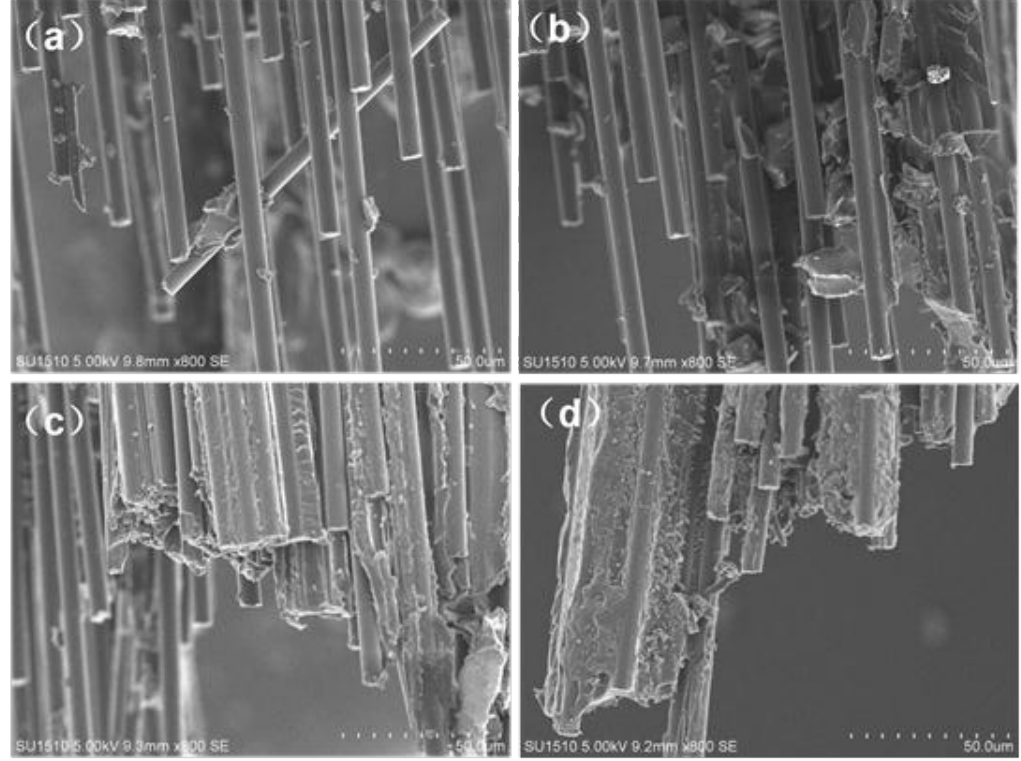
Figure 10. The SEM images of the fracture surface of CF composites ( a ) EP/CF; ( b ) MWCNTs-OH/EP/CF; ( c ) GnPs-OH/EP/CF; ( d ) hybrid materials/EP/CF.